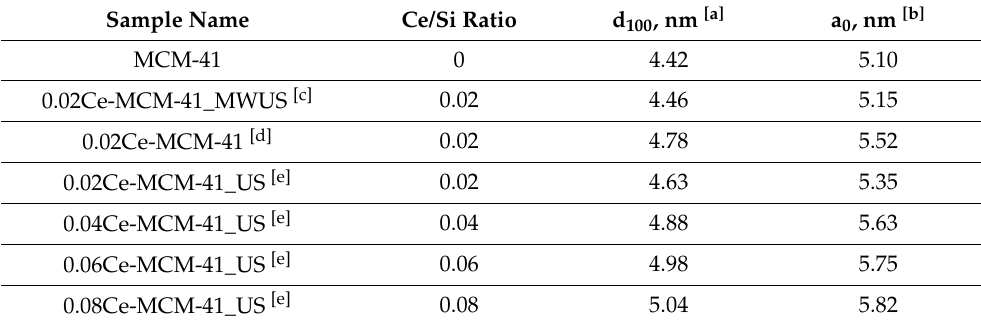
Table 1. Lattice cell parameters for Ce-modified mesoporous silica sieves.